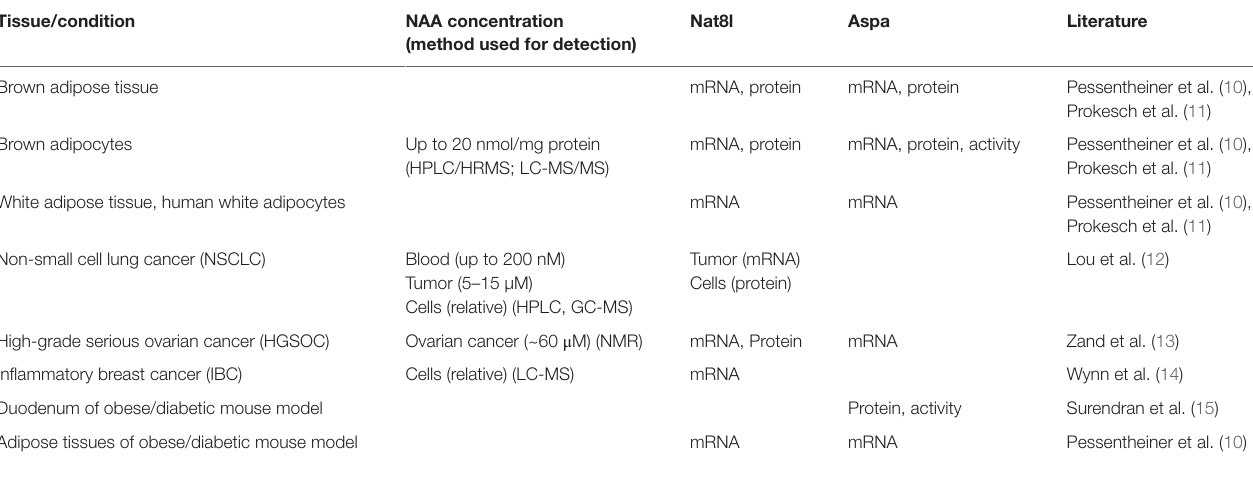
TABLe 1 | Body regions/conditions in which NAA concentrations and/or Nat8l/Aspa expression have been determined in physiological and pathological conditions outside the CNS. Tissue/condition nAA concentration (method used for